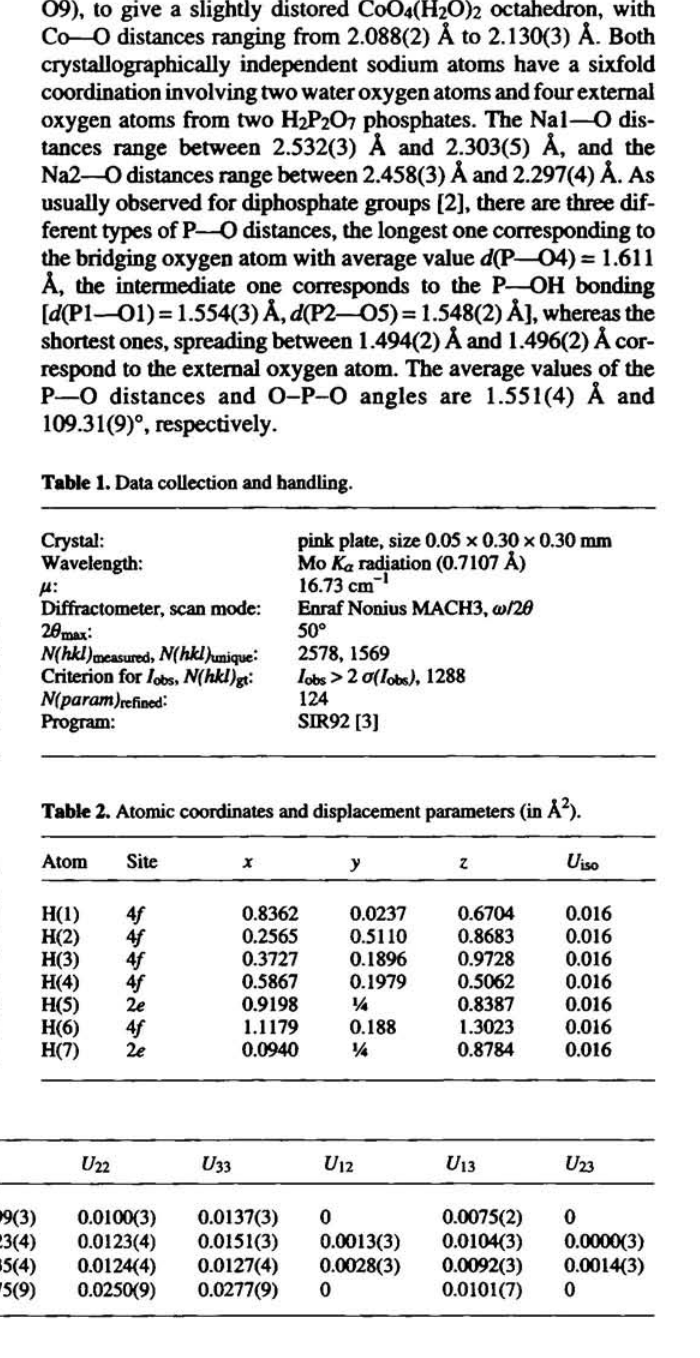
Table 3. Atomic coordinates and displacement parameters (in Â 2 ).